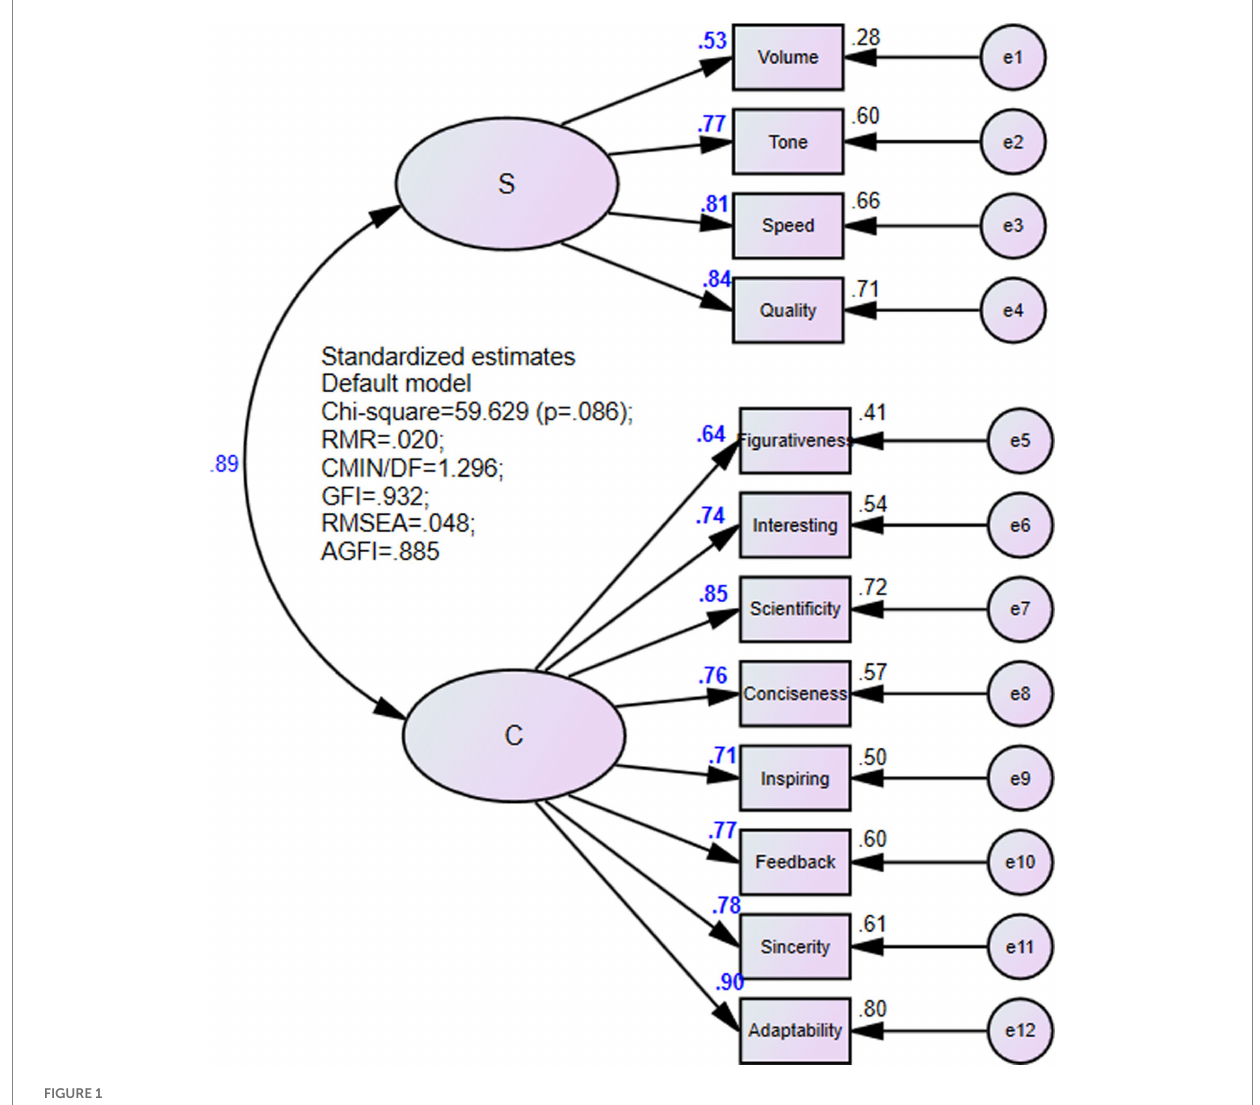
FIGURE 1 The adaptation result of the measurement model.